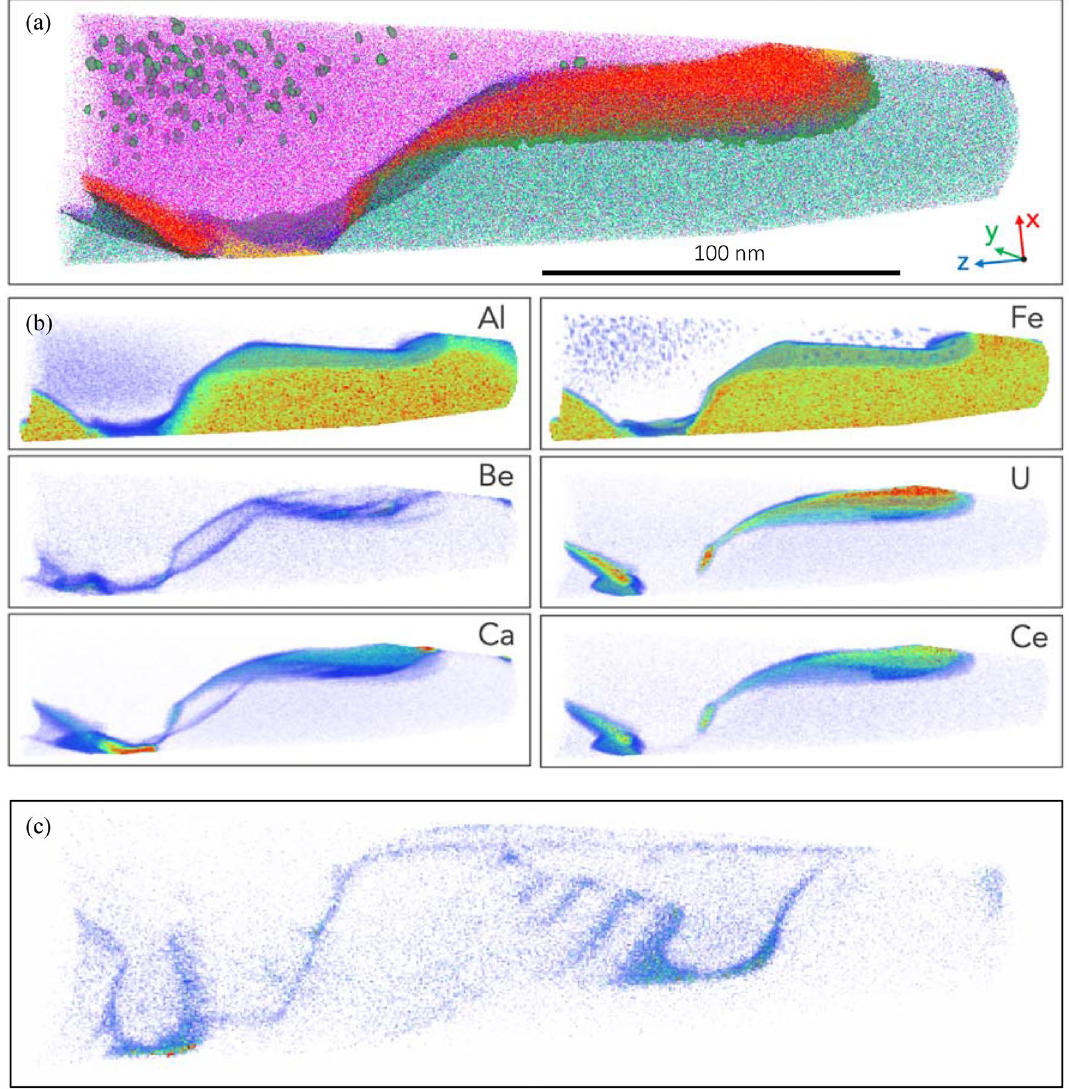
Figure 5. ( a ) APT analysis of specimen 1592 ( a ) 3D reconstructed atom map of a multiphase region within APT specimen. Atoms are displayed for Mg (purple), U and Ce (red), Ca and V (yellow), Fe and Al (green), Be (blue). Iso-concentration surfaces correspond to 11 at% U (red), 20 at% Mg (purple), and 30 at% Ca (yellow). The reconstructed volume is ~ 300 nm in length with the images compiled from ~ 34 M atoms. ( b ) 3D renderings of selected element concentrations using a color/transparency scale. ( c ) Volume rendered image of the Be complexion rotated 50 degrees to highlight the complex interfacial association along adjacent mineral